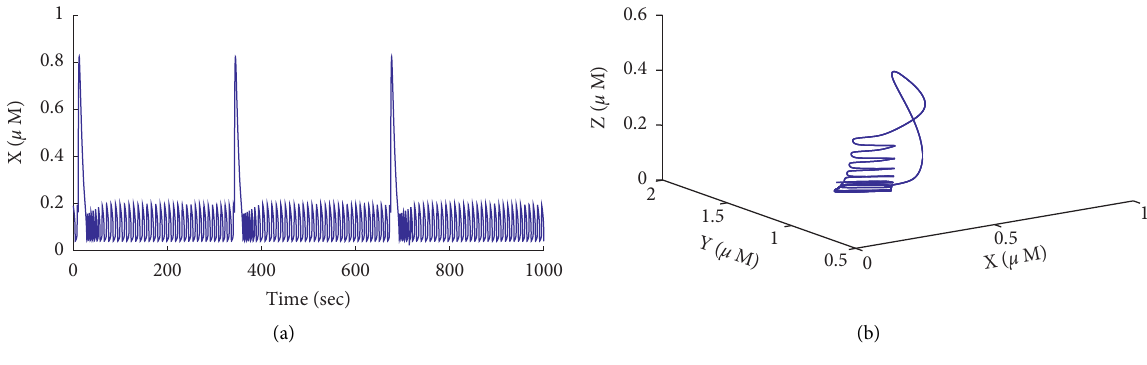
Figure 8: Shape, amplitude, and magnitude control of chaotic Ca 2+ oscillation in coupled model (7) of the glia cell system for the parameter r in � 0.05025. (a) The respective time course of variable Ca cyt with controlling rate parameters k c1 � 0.001, k c2 � 0.01. (b) 3D projection of the trajectory in (Ca cyt , Ca cyt , IP 3 ) phase space with controlling rate parameters k c1 � 0.001, k c2 �